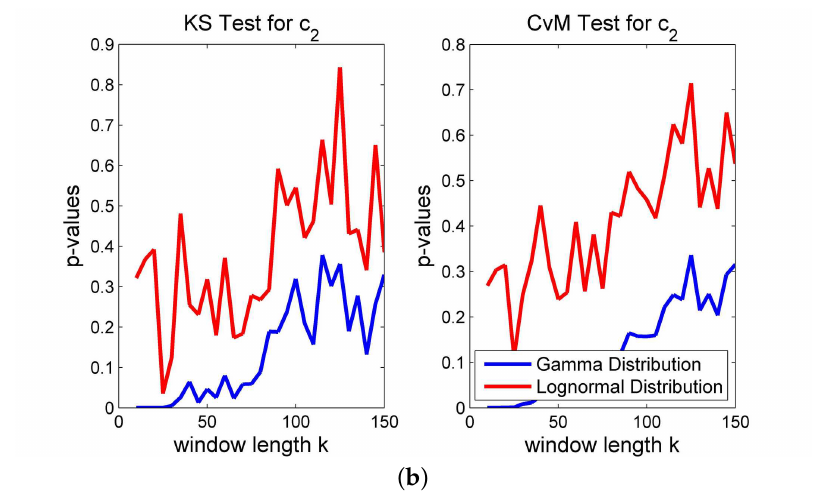
Figure 7. Different measures of fit for eigenvalues resp. c λ